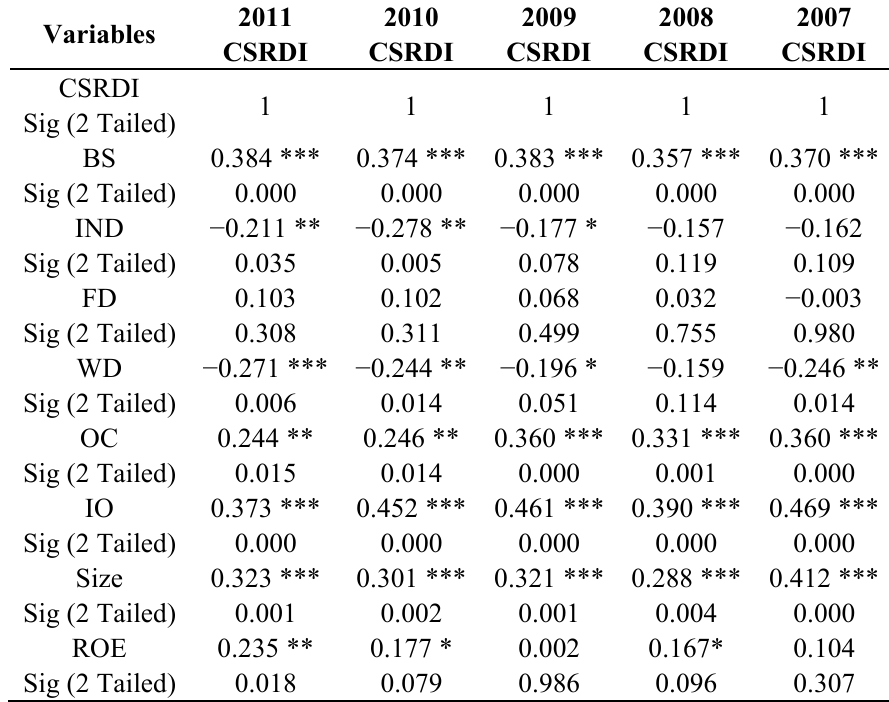
Table 4 . Pearson